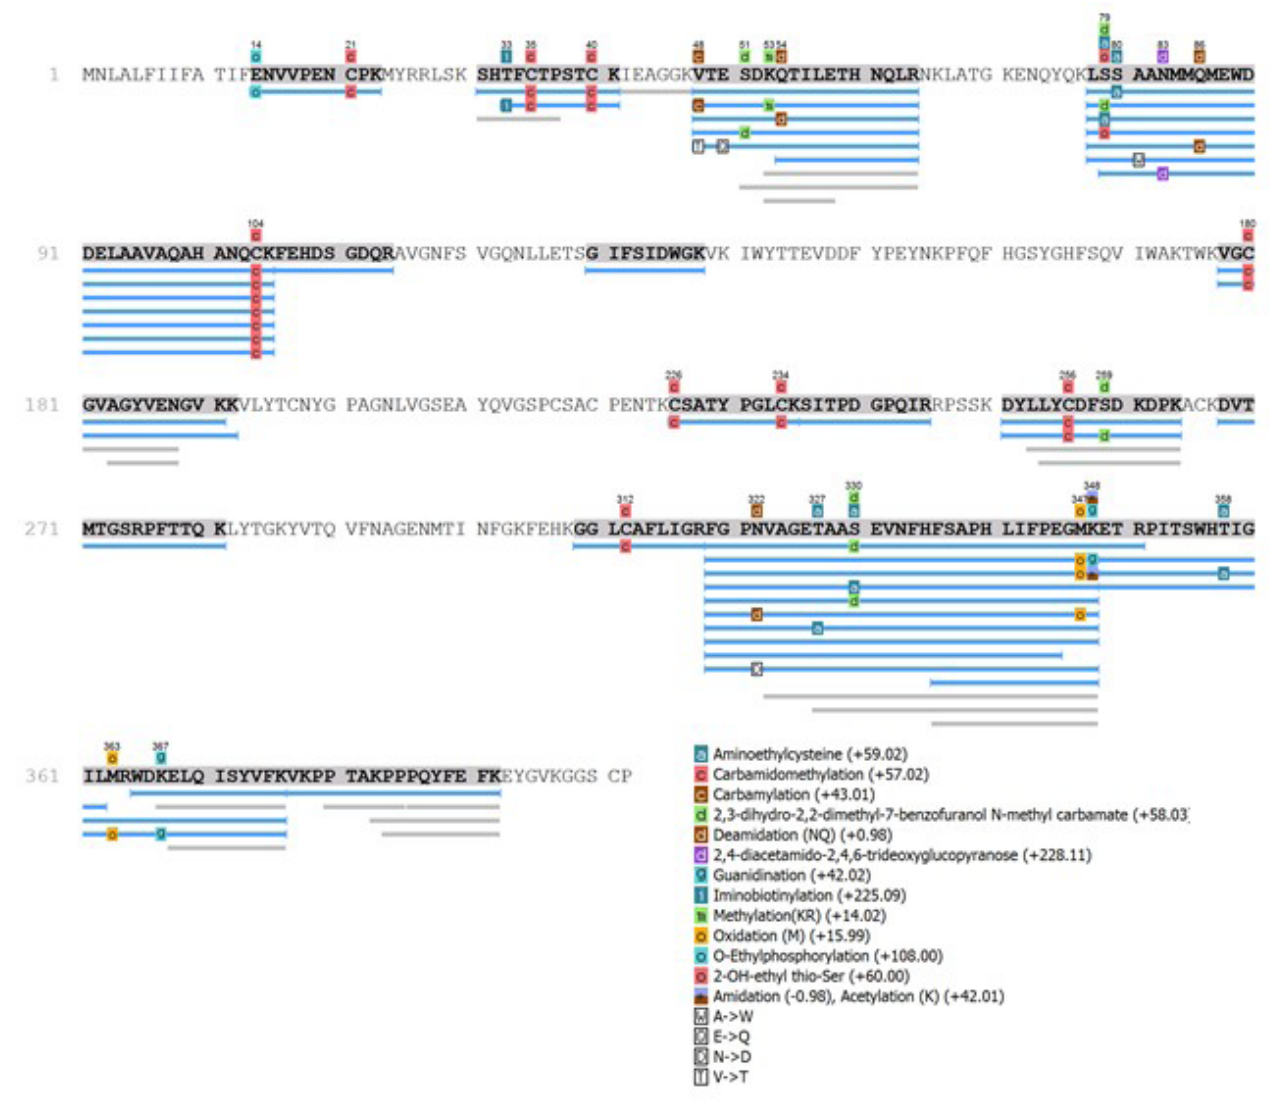
Figure 4. De novo sequencing of the CRISP identified in the Fraction I using the JAW07031.1 (putative cysteine-rich protein from Tityus serrulatus ) as a